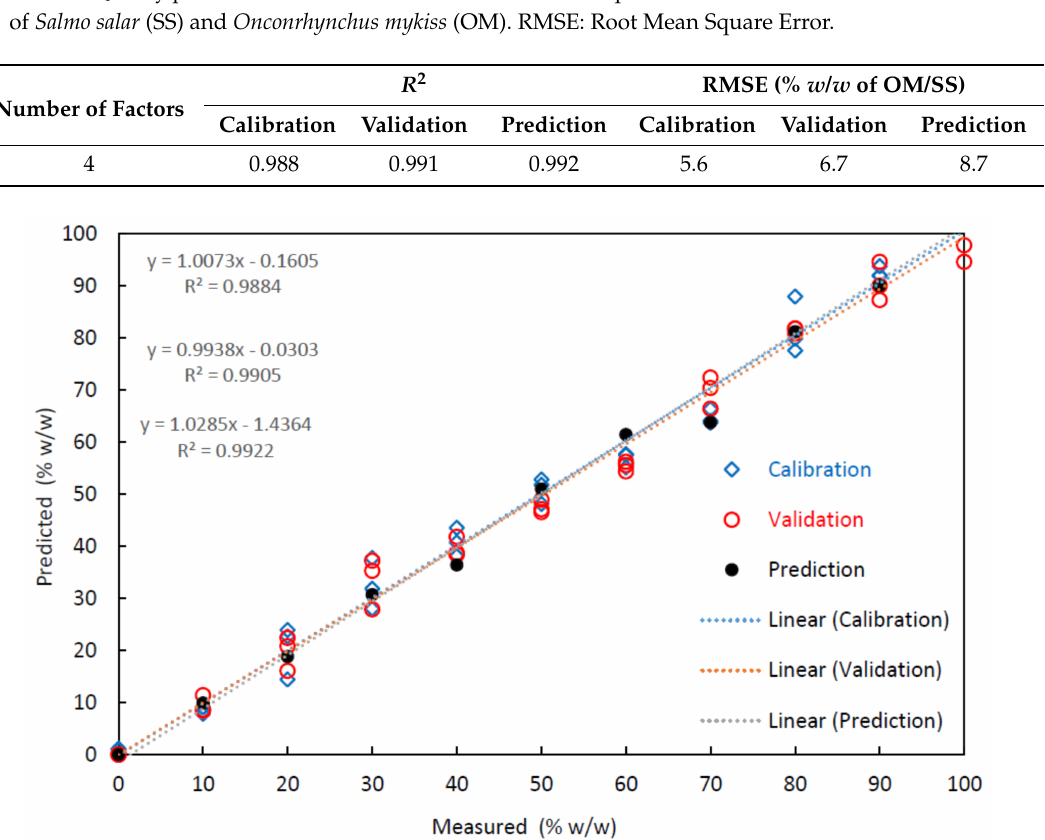
Table 4. Quality parameters of the multivariate model for the quantification of adulteration of mixtures